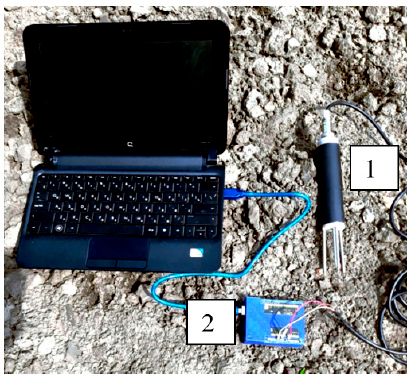
Figure 1. Soil moisture measuring kit: 1—SHS-1; 2—Arduino Uno.